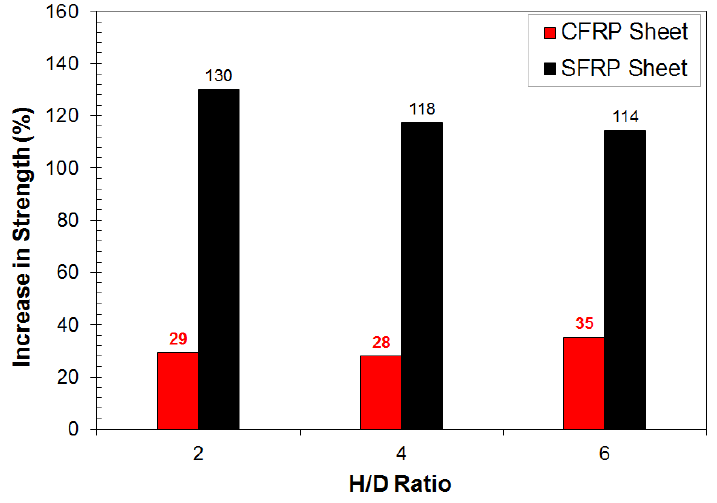
Figure 3. Percentage increase in the strength of the aspect ratio columns wrapped with SFRP and CFRP